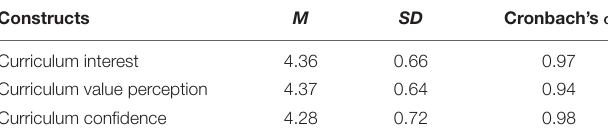
TABLE 1 | Reliability analysis.